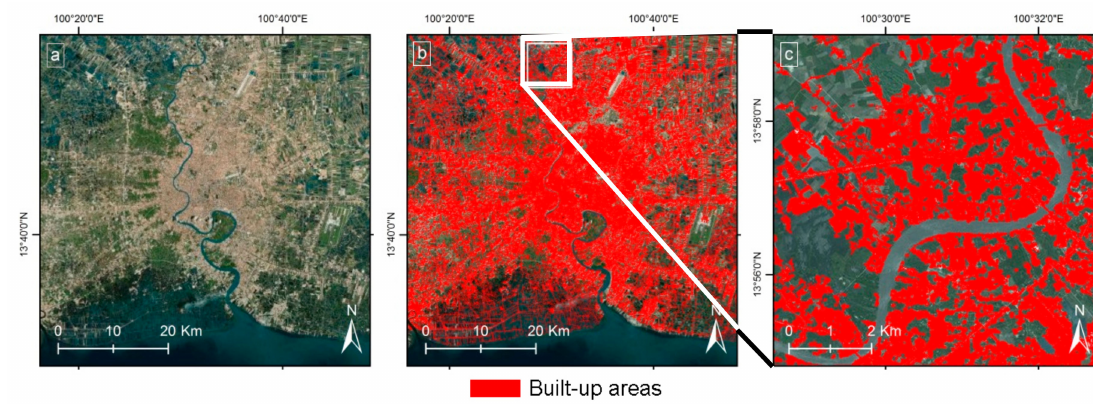
Figure 11. Urban surfaces (built-up area) in the Chao Pharya River Delta area in Bangkok, Thailand. Shown are a true color aerial image of the delta ( a ), built-up areas (red) for the same area ( b ) and a smaller excerpt ( c ), see ( b ) for location of bounding box) as mapped by the Global Urban Footprint for 2015 from TerraSAR-X